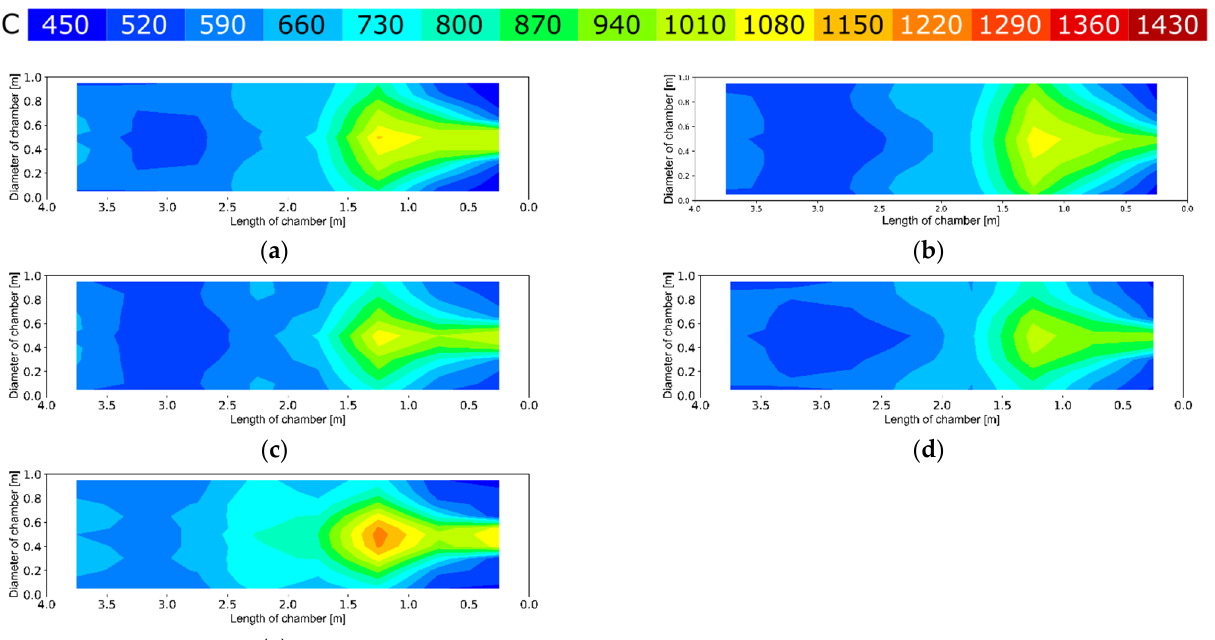
Figure 10. Influence of inert gas addition on flame temperatures—low-calorific burner—Burner C: ( a ) regime with the addition 60 m N3 /h of N 2 ; ( b ) regime with the addition 60 m N3 /h of CO 2 ; ( c ) regime with the addition 120 m N3 /h of N 2 ; ( d ) primary regime with the addition 120 m N3 /h of CO 2 ; ( e ) regime without inert gas addition.